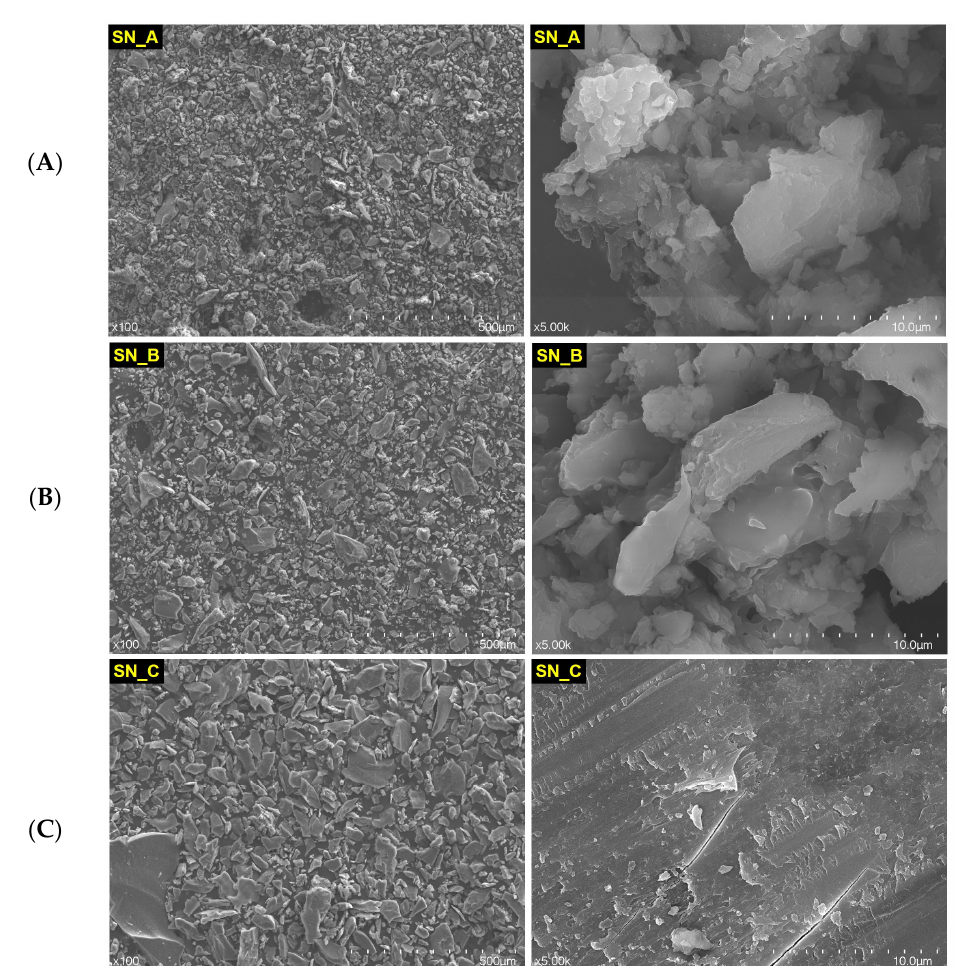
Figure 3. SEM images of SN restorative material powder, nonexposed ( A ) and exposed (rough ( B ) and fine ( C )) to acidic artificial saliva.